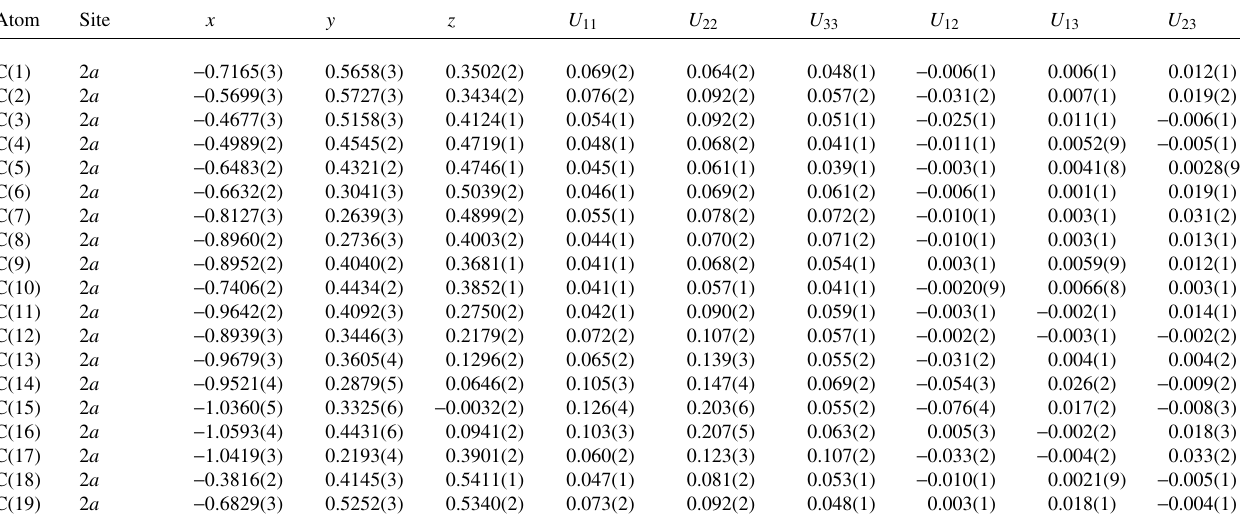
Table 3. Atomic coordinates and displacement parameters (in Å 2 ) .